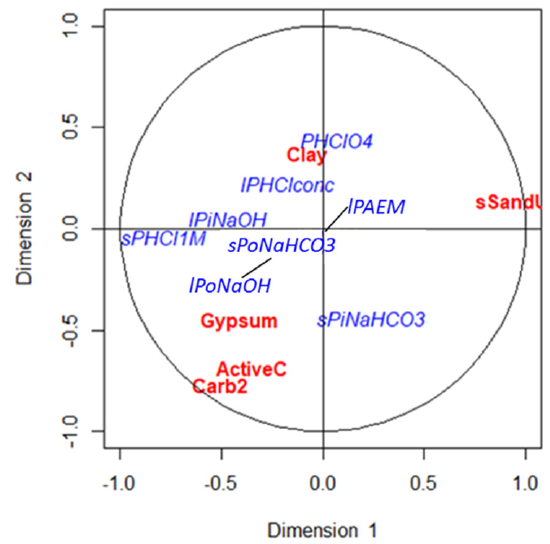
Figure 3. Variables plot for the first and second canonical dimensions of the Canonical Correlation Analysis performed to the P fractions and the soil composition parameters. Abbreviations for soil parameters as in Table S2.